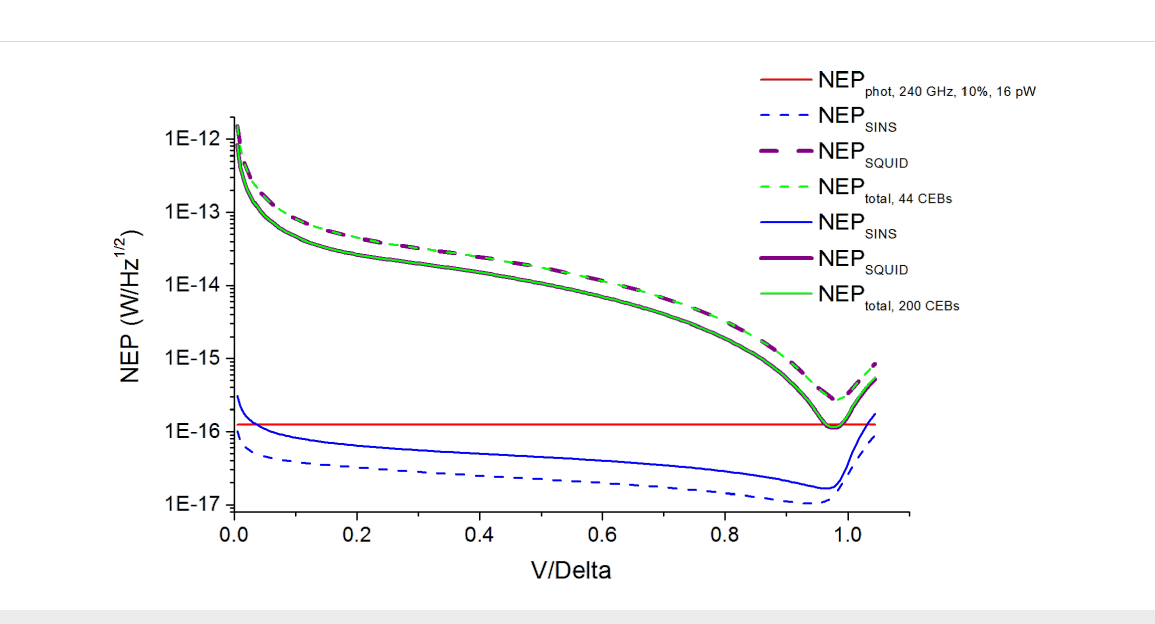
Figure 9: NEP estimations for the 240 GHz channel with 16 pW power load. Dashed curves are for 44 SINS CEBs; solid curves are for 200 SINS